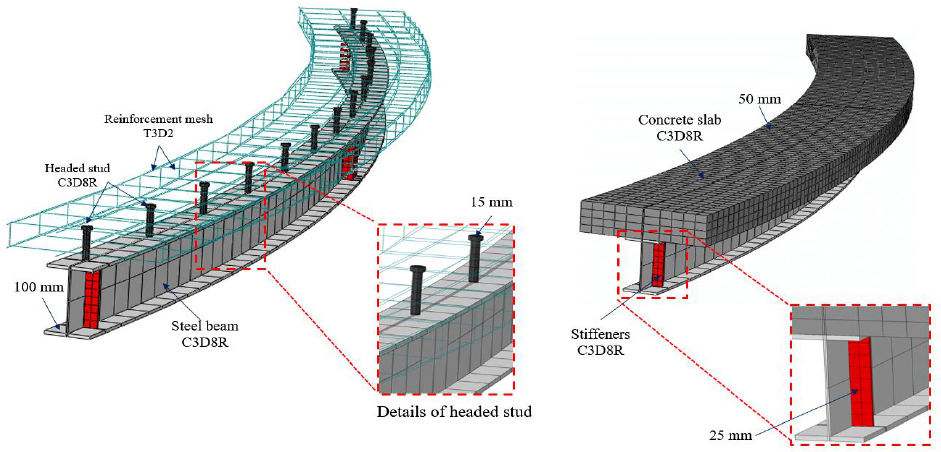
Figure 4. The model of the beam in the ABAQUS program